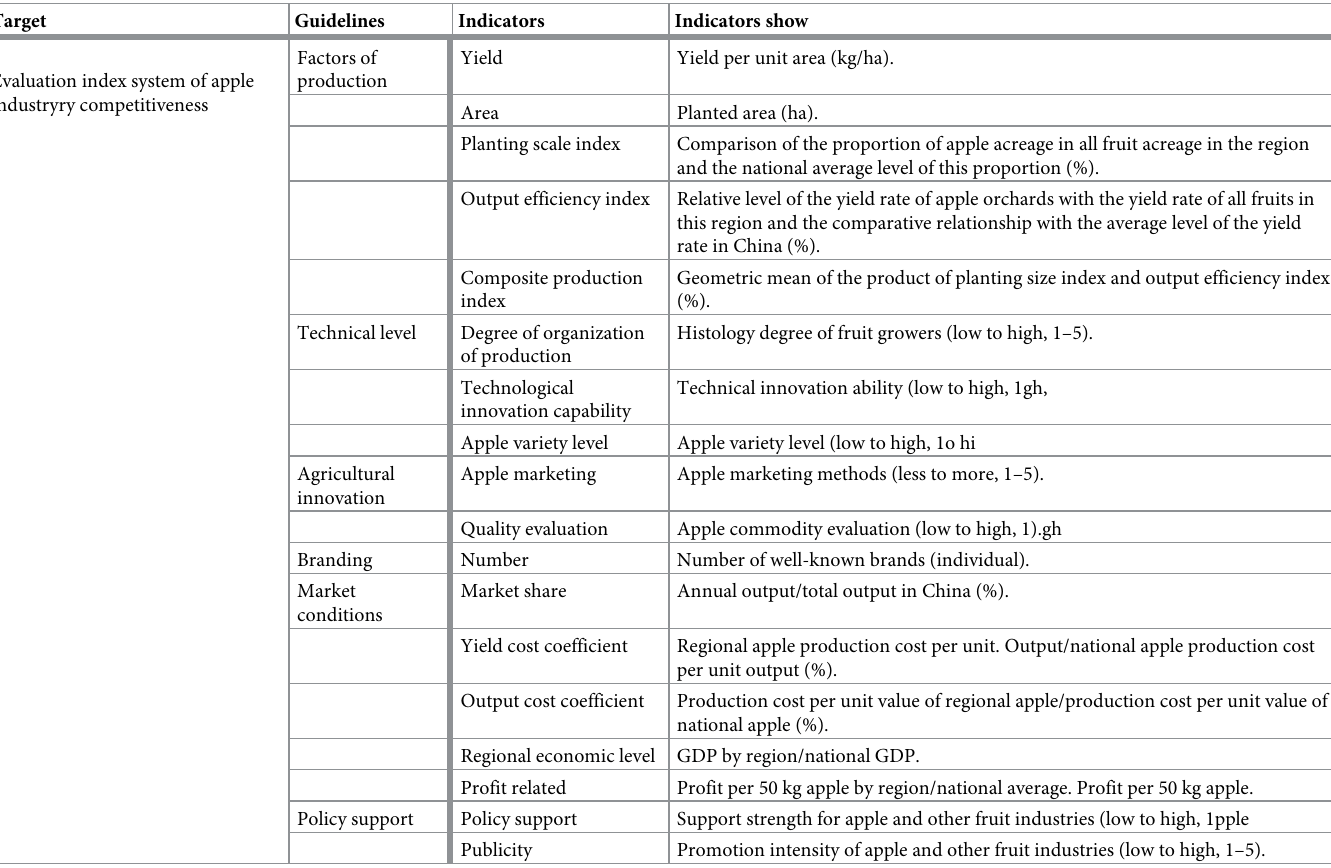
Table 1. Evaluation index system for apple industry